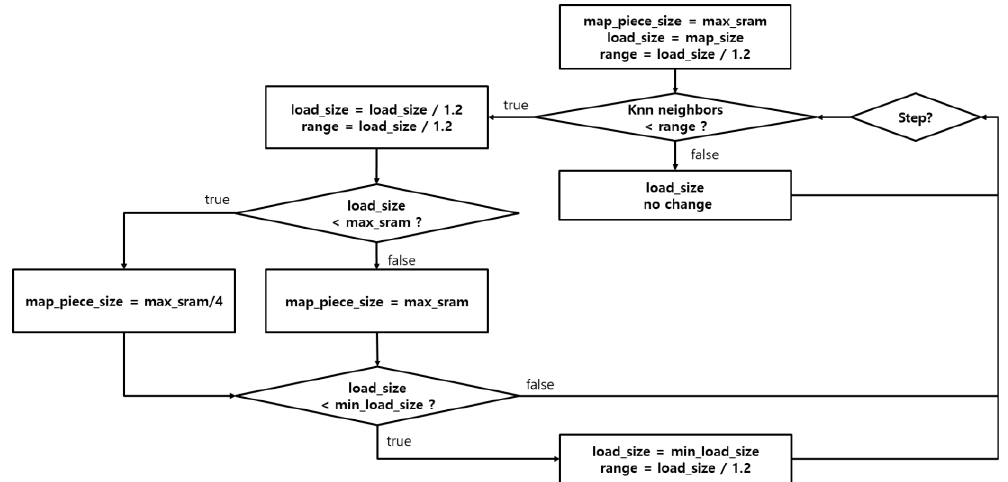
Figure 5. Flow chart of the algorithm to determine the size of the magnetic field map to load to SRAM.